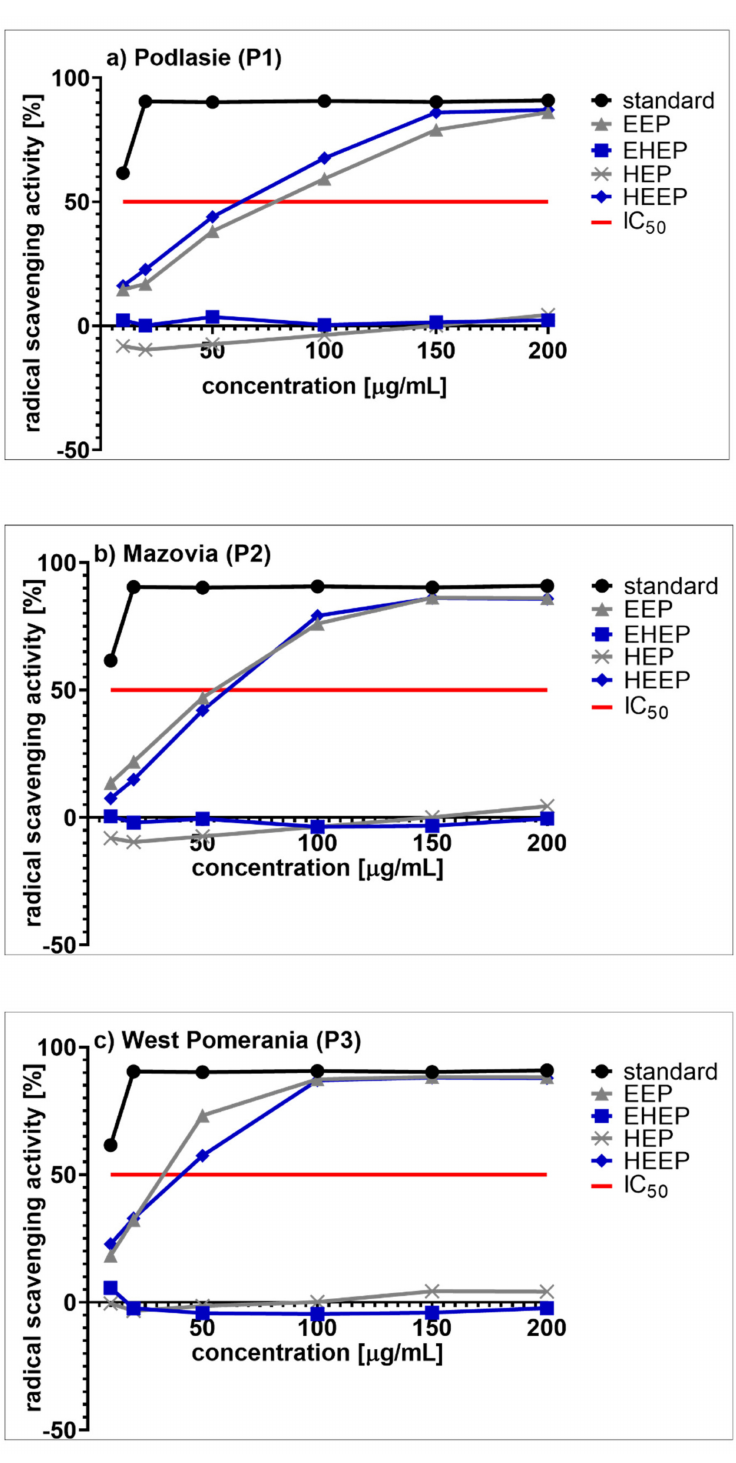
Figure 1. DPPH free radical scavenging activity of the prepared propolis extracts from: ( a ) Podlasie (P1); ( b ) Masovia (P2); ( c ) West Pomerania Province (P3); EEP— ethanol extract of propolis, EHEP—ethanol-hexane extracts of propolis, HEP—hexane extract of propolis,